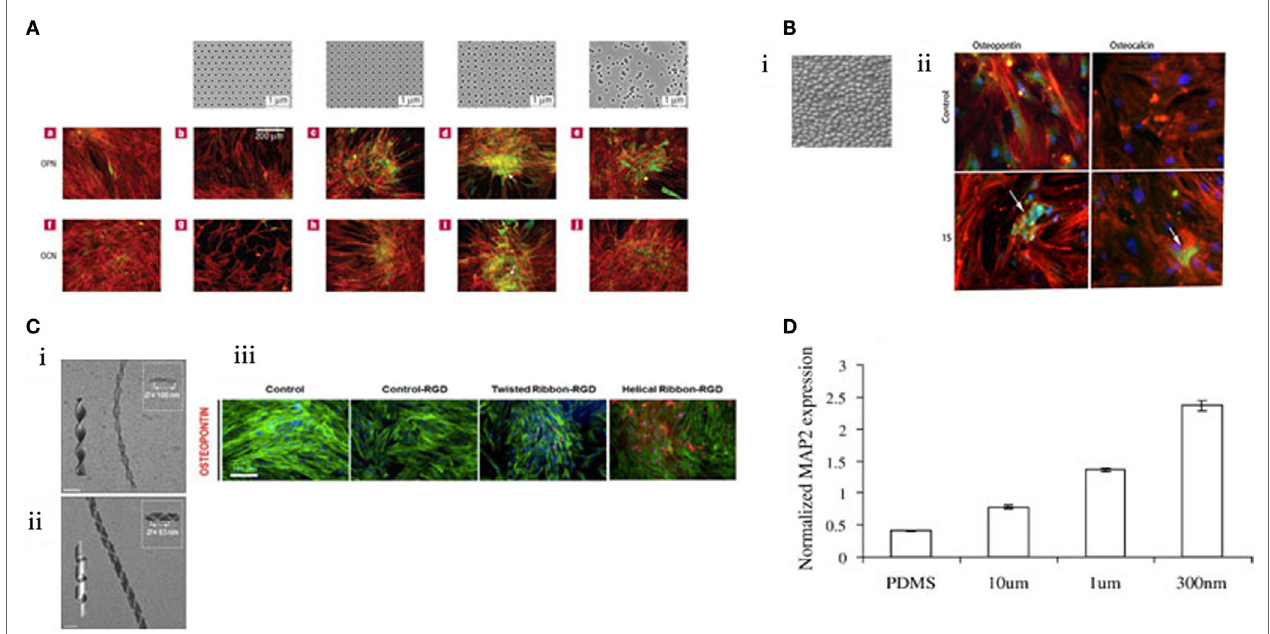
FiGURe 3 | MSC response to topographical features . (A) EBL nanopatterned structures result in changes in gene expression. Those that exhibited “disorder” were found to stimulate osteogenesis. Reprinted (adapted) from Nature, copyright (2007) (Dalby et al., 2007). (B) i. Titanium was anodized to create a topography of 15 nm pillars. ii. These pillars were found to be osteoinductive by immunostaining for osteopontin and osteocalcin (green). Reprinted (adapted) from Acta Biomaterilia , copyright (2009) (Sjöström et al., 2009). (C) Creation of twisted nanoribbons at a periodicity similar to that of collagen (ii) resulted in osteogenic phenotype. (iii) Reprinted (adapted) from ACS Nano, copyright (2013) (Das et al., 2013). (D) MSCs can be differentiated toward a neural lineage using nanoscale channels, characterized by increasing MAP2 expression. Reprinted (adapted) from Experimental Cell Research, copyright (2007) (Yim et al.,